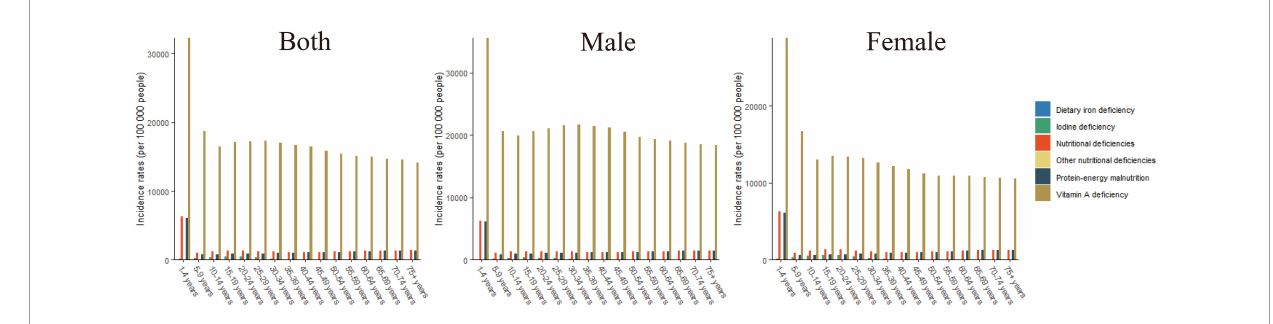
FIGURE2 The incidence rates of overall nutritional deficiency and its main subcategories by age groups in 2019.